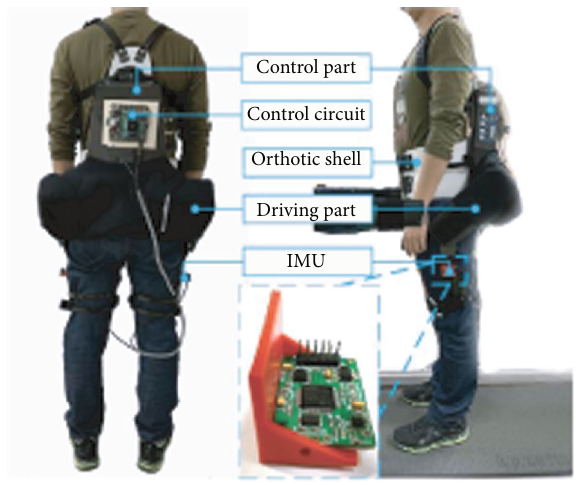
Figure 1: The hardware of the system, including the active pelvic orthosis (APO) and the IMU for measurement.